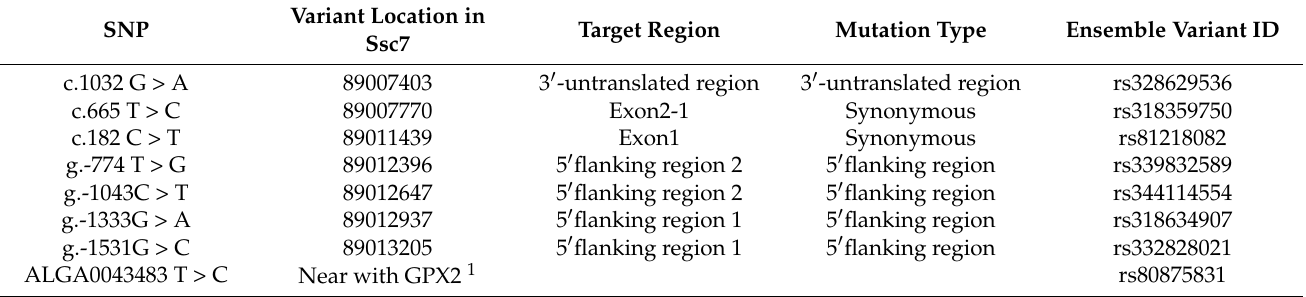
Table 1. Genotyping assay for ALGA0043483 and seven SNPs for the GPX2